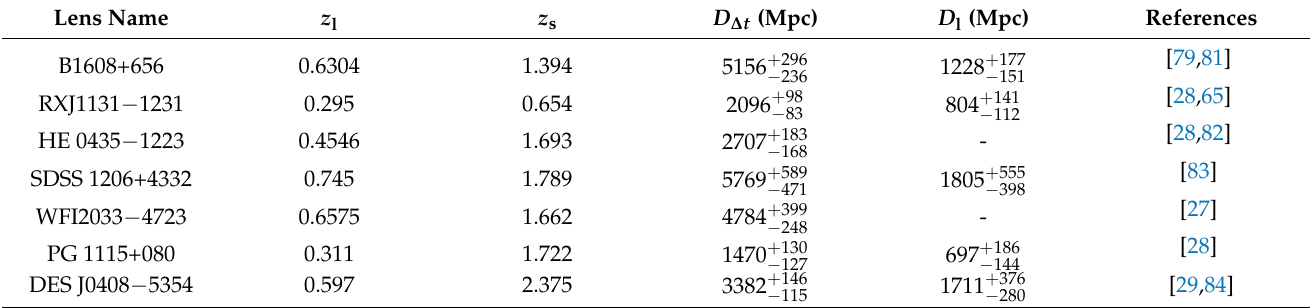
Table 1. D ∆ t and D l for the seven